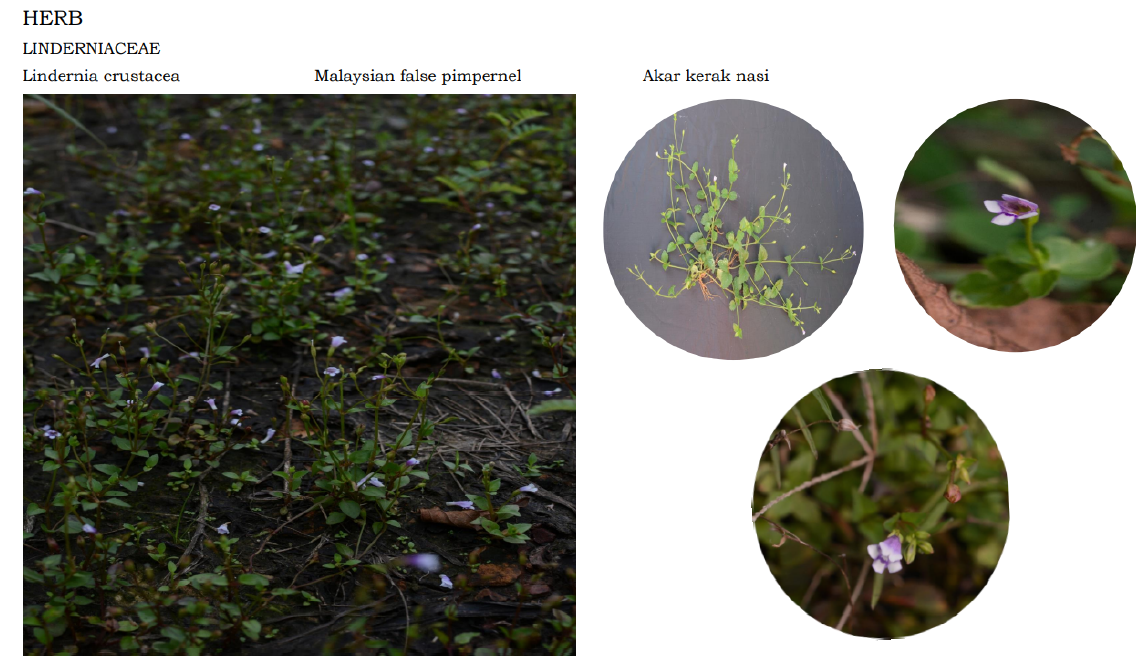
Figure A1 . Herb Asteraceae: Ageratum conyzoides.